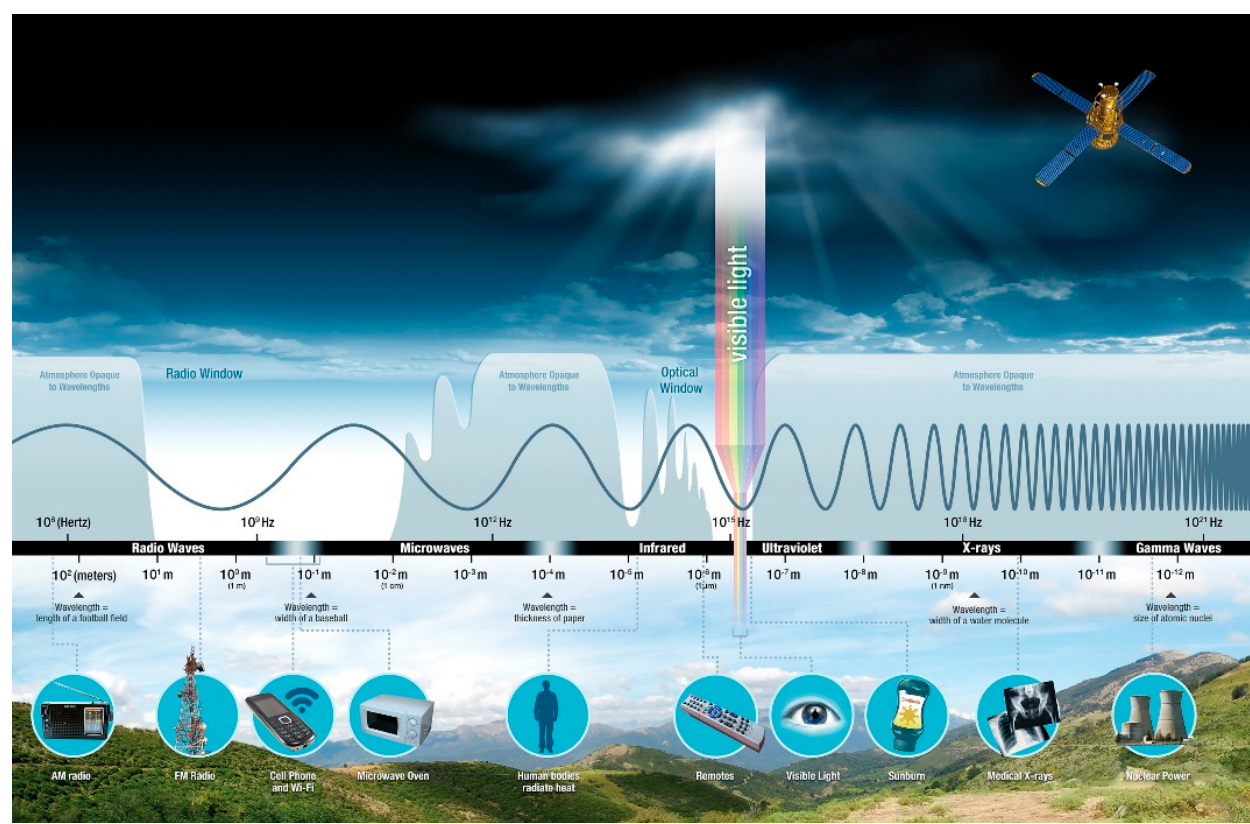
Figure 1. Electromagnetic spectrum (https://smd-prod.s3.amazonaws.com/science-red/s3fs-pub- lic/thumbnails/image/EMS-Introduction.jpeg, accessed on 20 November 2022).accessed on 20